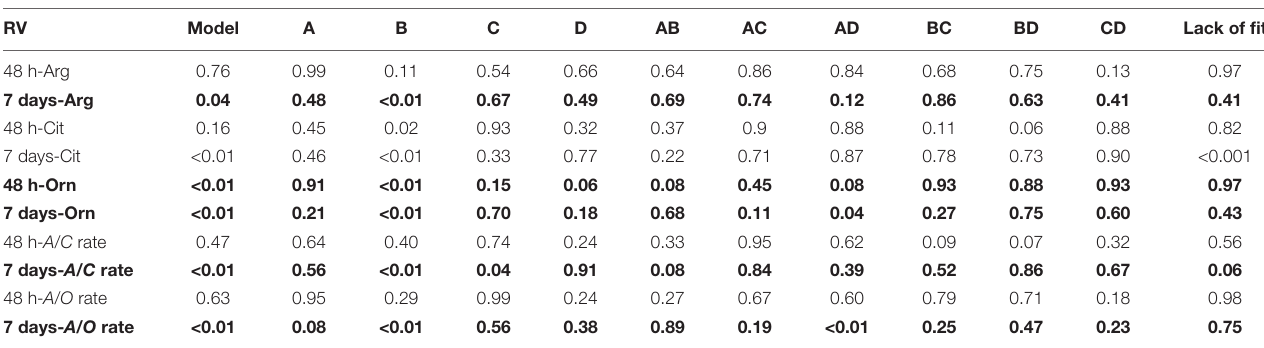
FIGURE 6 | The effect of phenolic compounds on citrulline accumulation of P. acidilactici (A) and W. confusa (B) . * and ** means the significant difference ( P < 0.05) and most significant difference ( P < 0.01) in 72 h-Cit compared with control. TABLE 2 | ANOVA for response surface quadratic model for CCD experiment ( P -